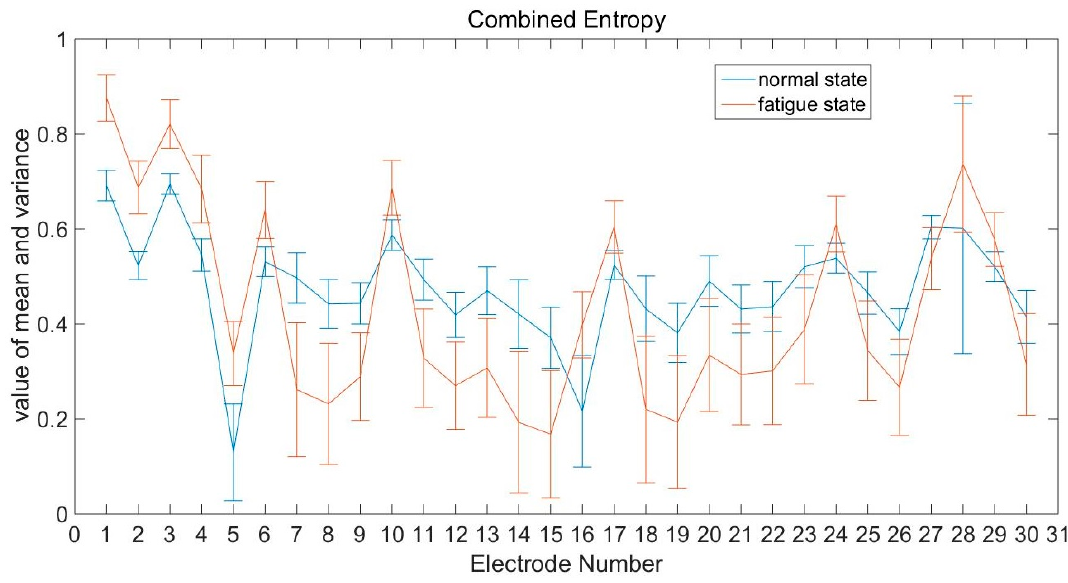
Figure 5. The value of mean and variance in two states with respect to the combined entropy. Table 1. The classification results. Acc : accuracy; Sn : sensitivity; Sp : specificity; MCC : Mathew´s correlation coefficient